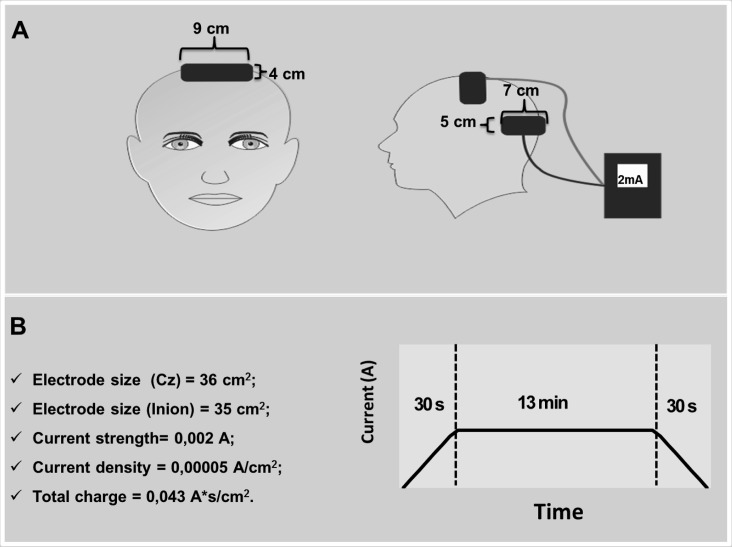
(A) Schematic illustration of the position of the electrodes during stimulation. (B) Stimulation parameters and an example of current ramp up and ramp down at the beginning and end of tDCS.